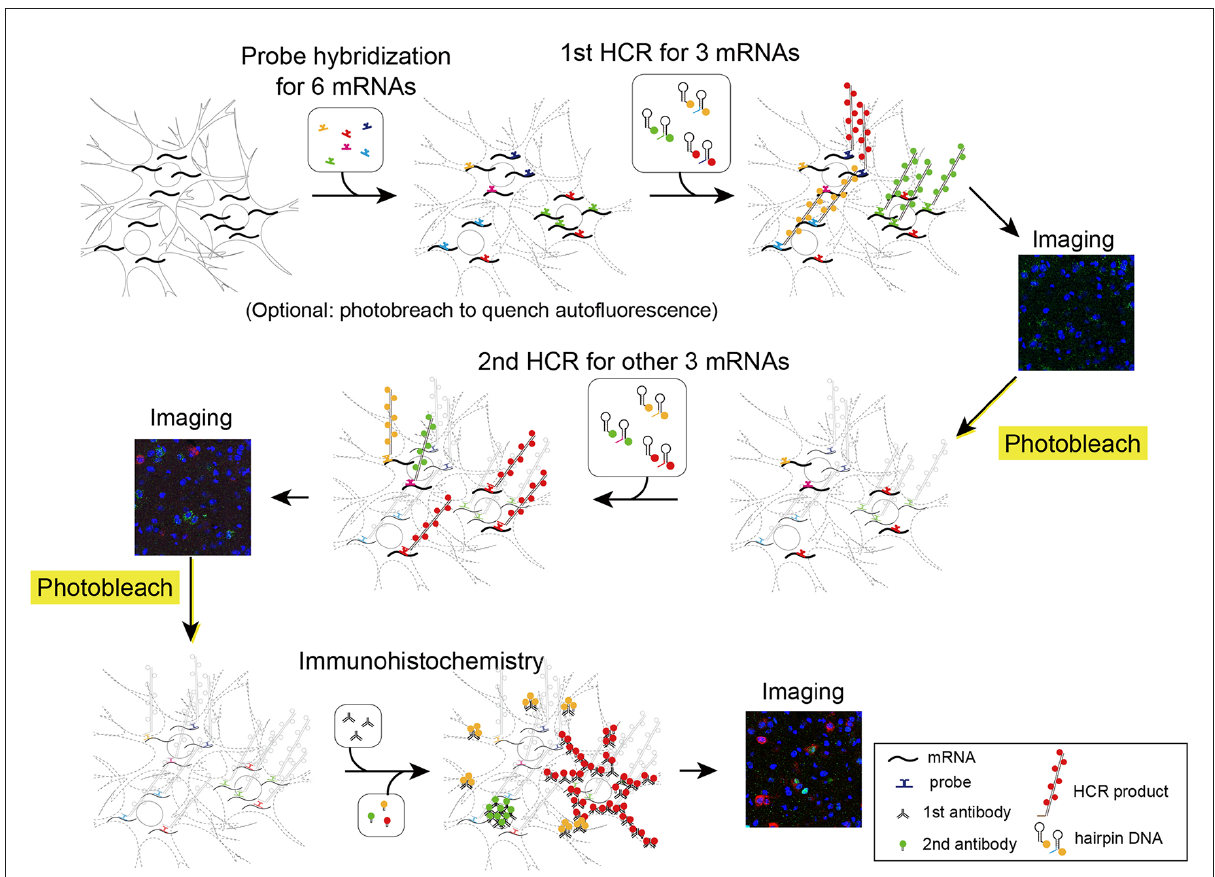
FIGURE5 Schematic illustration describing two rounds of ISH combined with IHC. First, all probes of mRNAs of interest were hybridized simultaneously. The tissue was subjected to two rounds of staining by HCR for three mRNAs, confocal imaging, and photobleaching. Then, the tissue was subjected to IHC and confocal